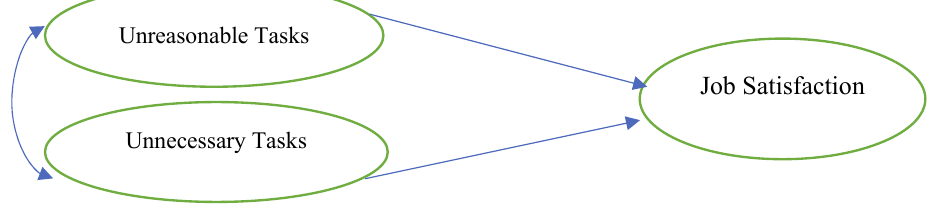
Fig. 1. Conceptual framework of illegitimate tasks and job satisfaction